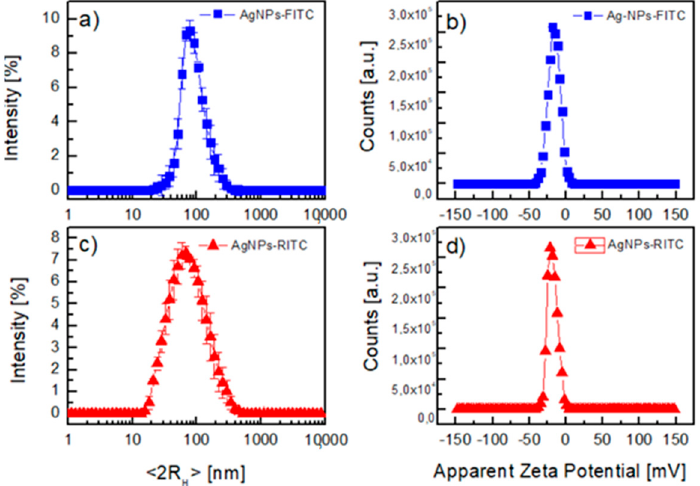
Figure 3. Dynamic light scattering (DLS) and zeta potential measurements for AgNPs in water at 25 °C: ( a ) AgNPs–FITC DLS <2R H > = 78 ± 12 nm; ( b ) AgNPs–FITC ζ potential = − 16 ± 3 mV; ( c ) AgNPs–RITC DLS <2R H > = 68 ± 20 nm; ( d ) AgNPs–RITC ζ potential = − 22 ± 3 mV.